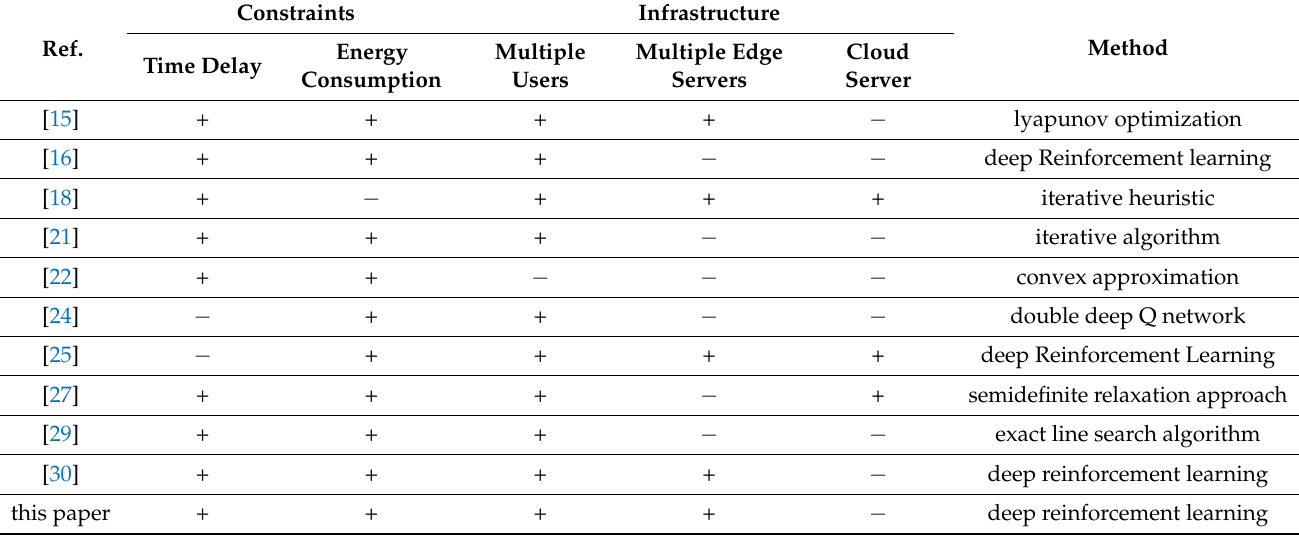
Table 1. The comparative analysis of different work (“+”: involved; “ − ”: not involved).